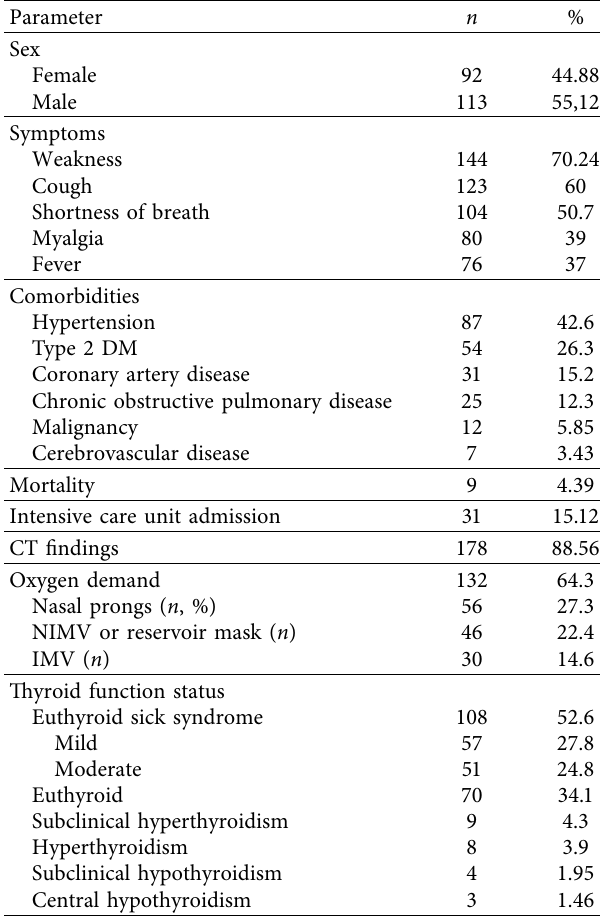
Table 2: Baseline characteristics of